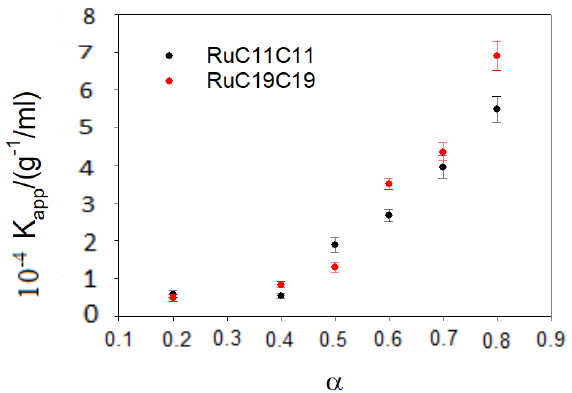
Figure 4. Dependence of the apparent equilibrium constant on the parameter α for the various prepared liposomes.